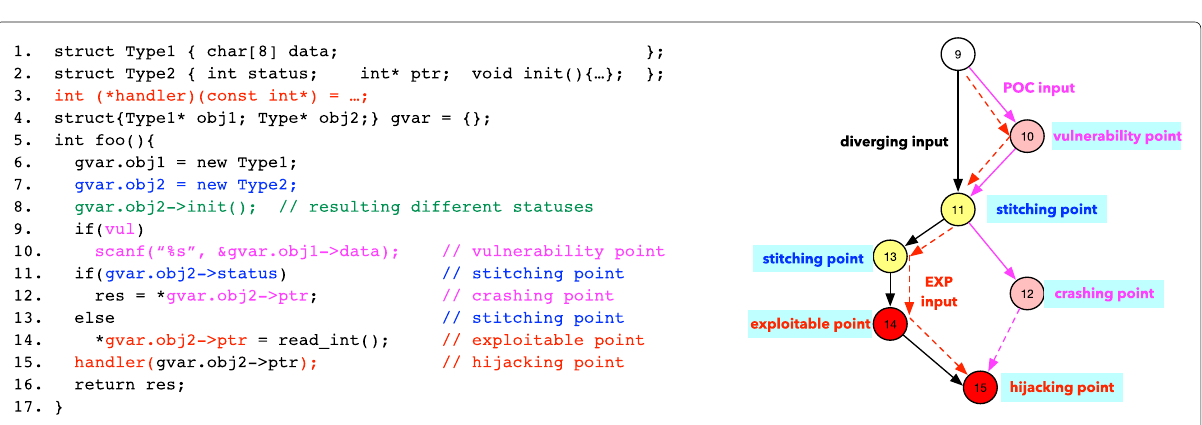
Fig. 1 An example heap overflow. The vulnerability at line 10 could overwrite the following object, i.e., obj2. PoC inputs would crash at line 12 and enter a non-exploitable state. Successful exploits will trigger the exploitable state at line